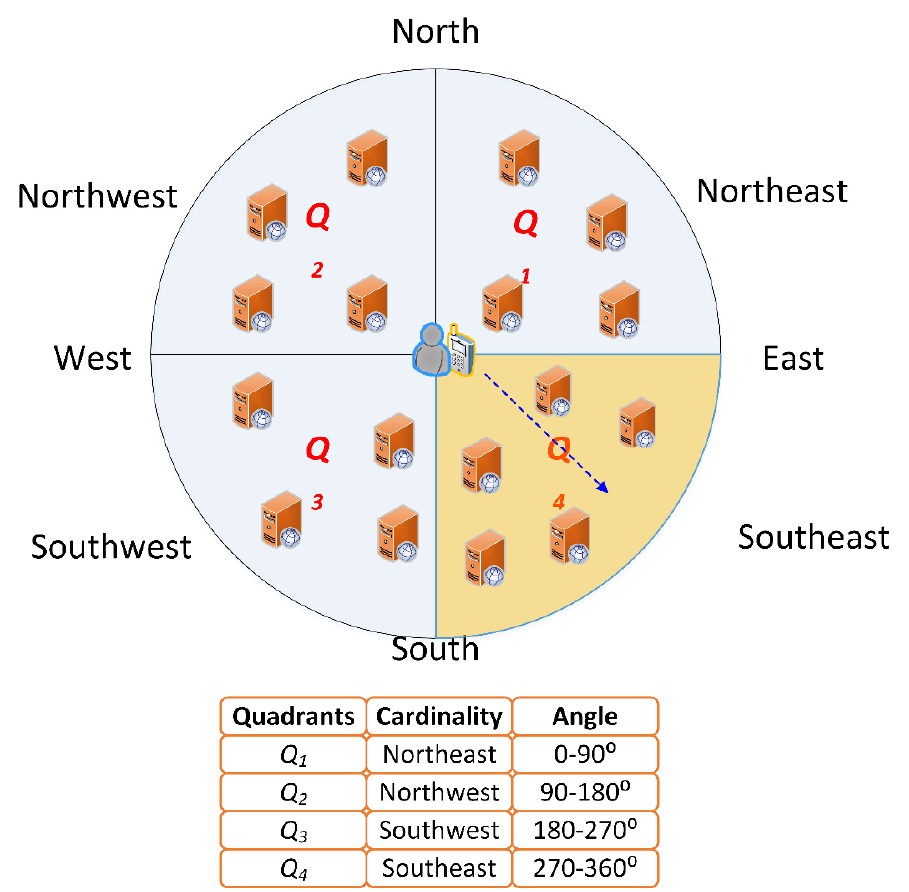
Figure A1. Mobile device orientation during movement.